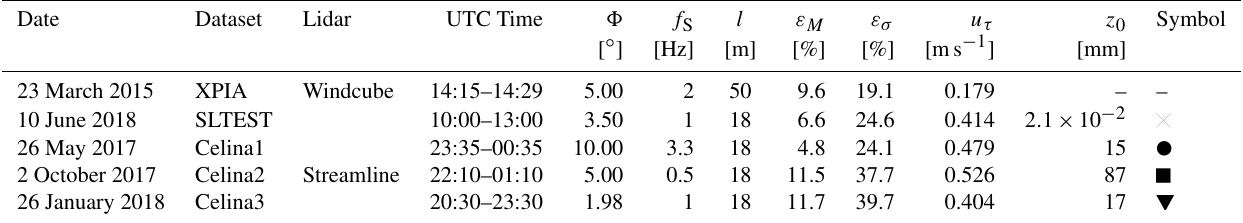
Table 2. Description of the selected datasets: (cid:56) is the lidar elevation angle, f S is the sampling frequency, l is the probe length, (cid:15) M is the absolute percentage error on the mean velocity, (cid:15) σ is the percentage error on the velocity variance, u τ is the friction velocity, and z 0 is the aerodynamic roughness length. The last column reports the symbol used for each